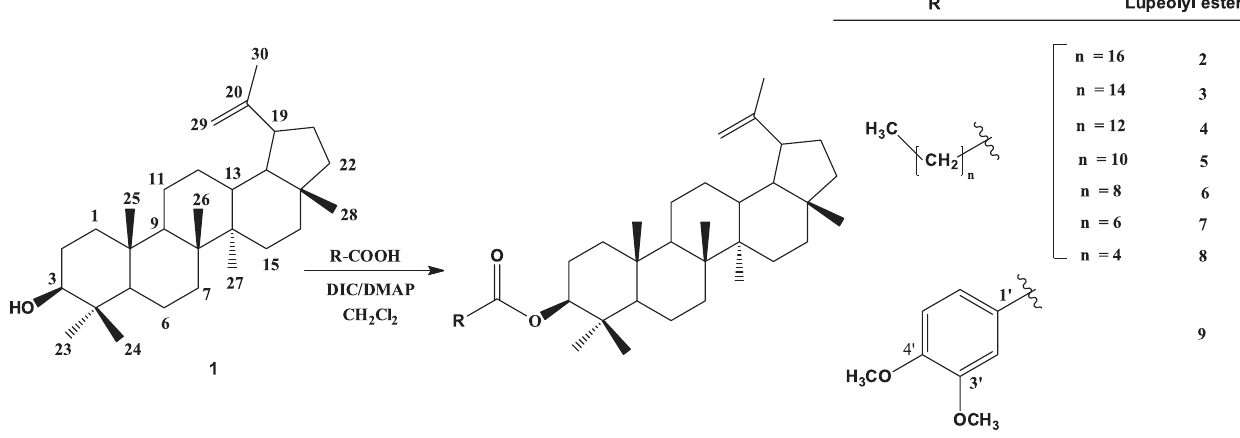
FIGURE 1 - Scheme of lupeol ( 1 ) esterification using DIC/DMAP reagents, to obtain lupeol esters 2 to 9